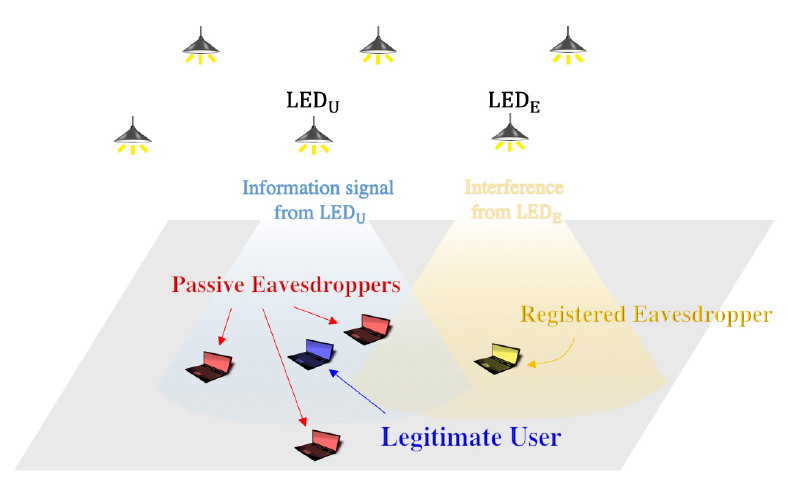
Figure 5. An example of a VLC system operating in presence of both registered and passive eaves- droppers.